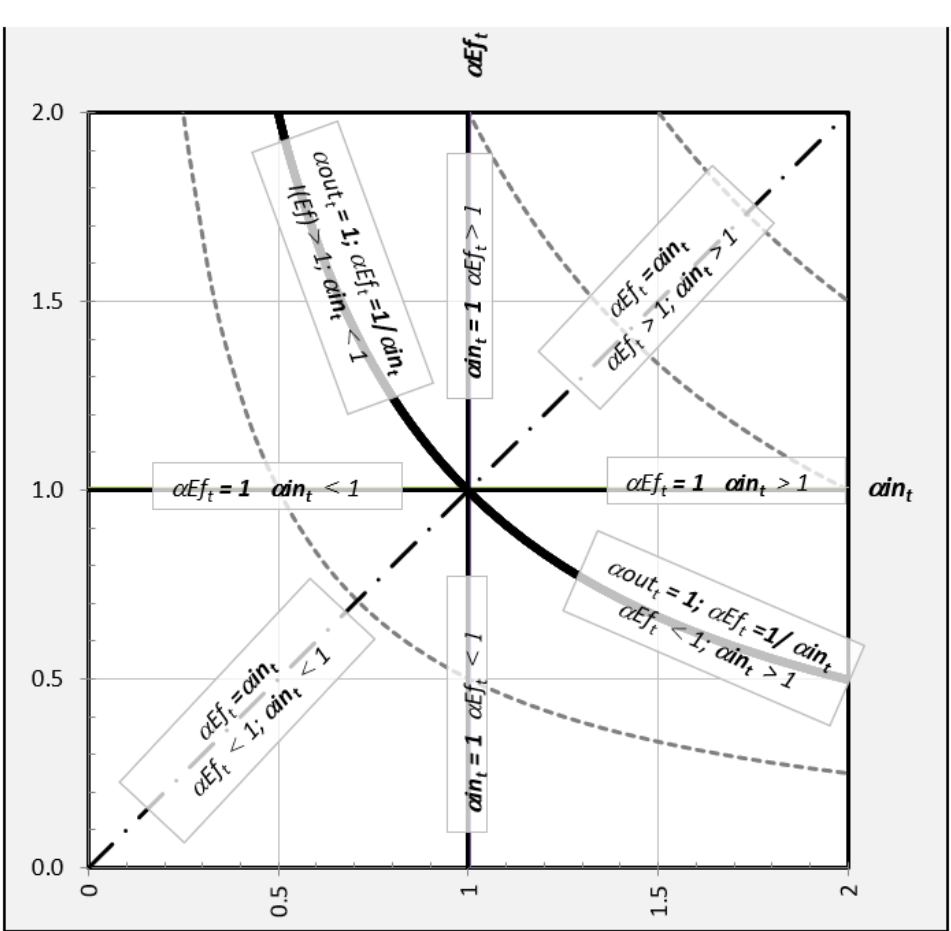
Figure 1. Space to display and describe the basic types of development observed in α out t , α in t , and α Ef t. Note: The range of the coefficients of both factors ( α Ef t and α in t ) in Figure 1 is selected to be in the interval from 0 to 2, i.e., from a decrease in output to zero through stagnation ( α Ef t = 1 or α in t = 1) to double growth. If using logarithmic coordinates, these isoquants would be linear.